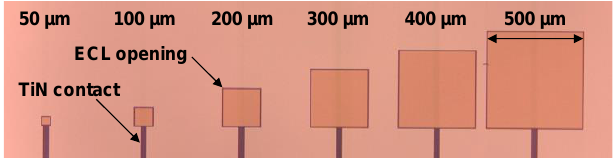
Figure 8. Microscope image of the silicon substrate with different pixel sizes showing TiN bottom contact and inorganic edge cover layer.